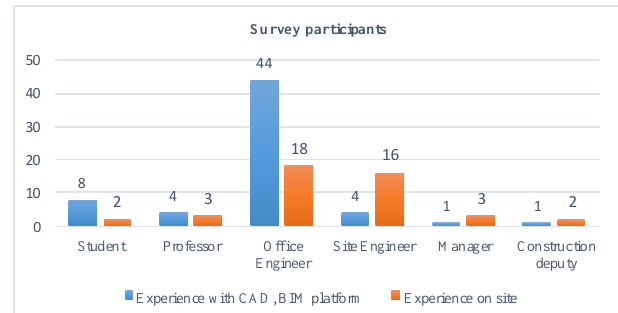
Fig. 5. Graphic show the user’s experience based on site or on CAD, BIM